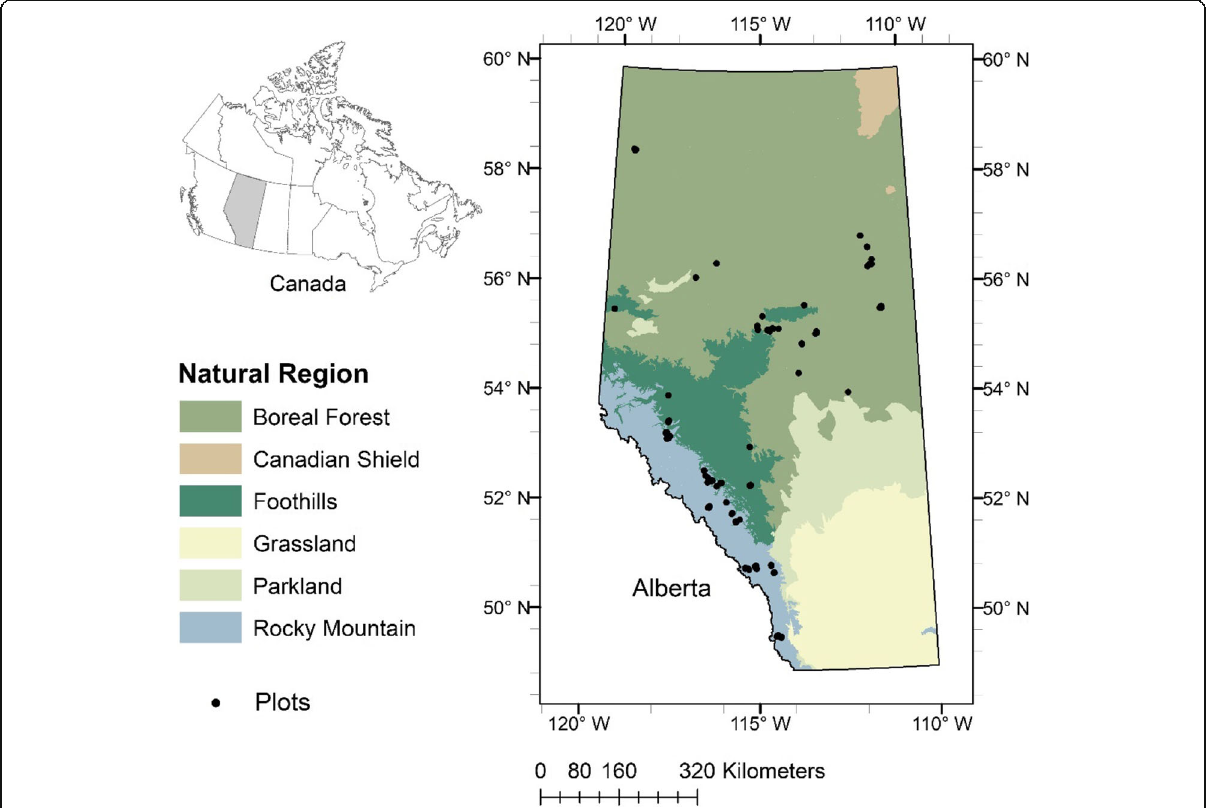
Fig. 1 Plot locations within the province of Alberta, Canada, by Natural Region (Natural Regions Committee